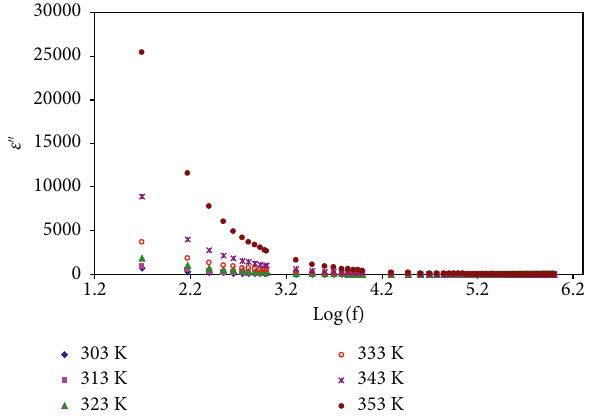
Figure 7: Dielectric loss versus frequency at various temperatures for the PBS1 blend sample.